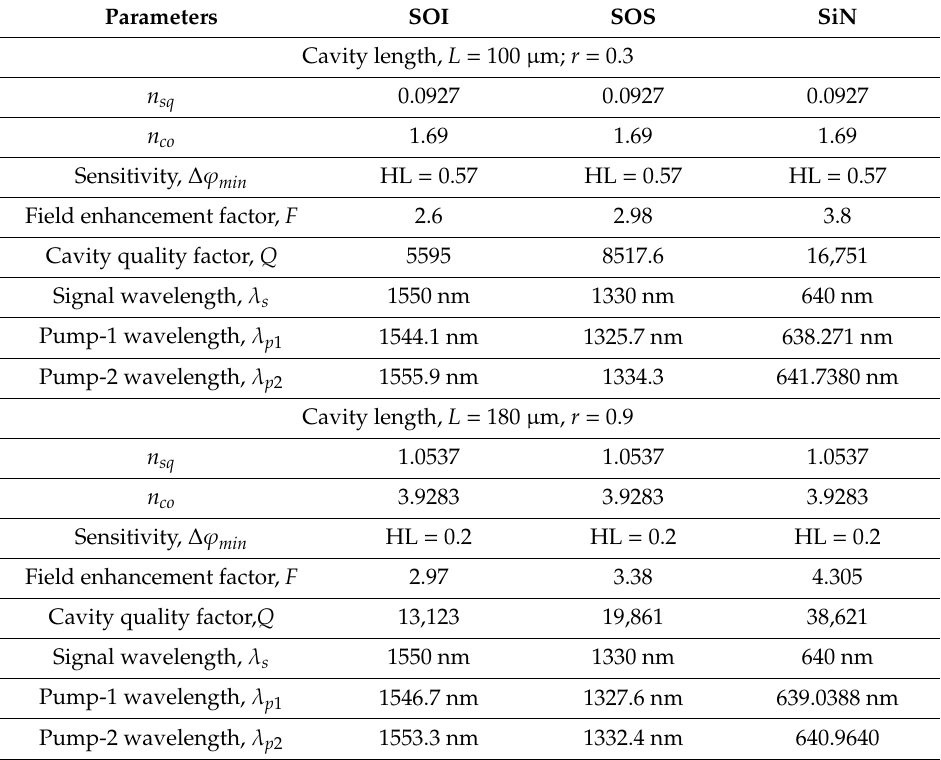
Table 1. Sensor designed